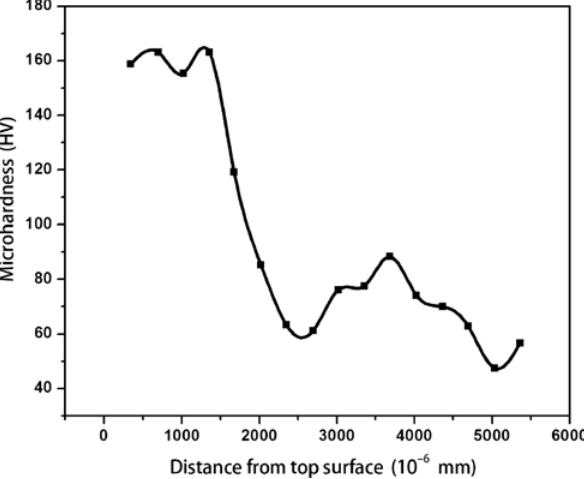
Figure 14: Variations of microhardness with change in distance from the top surface